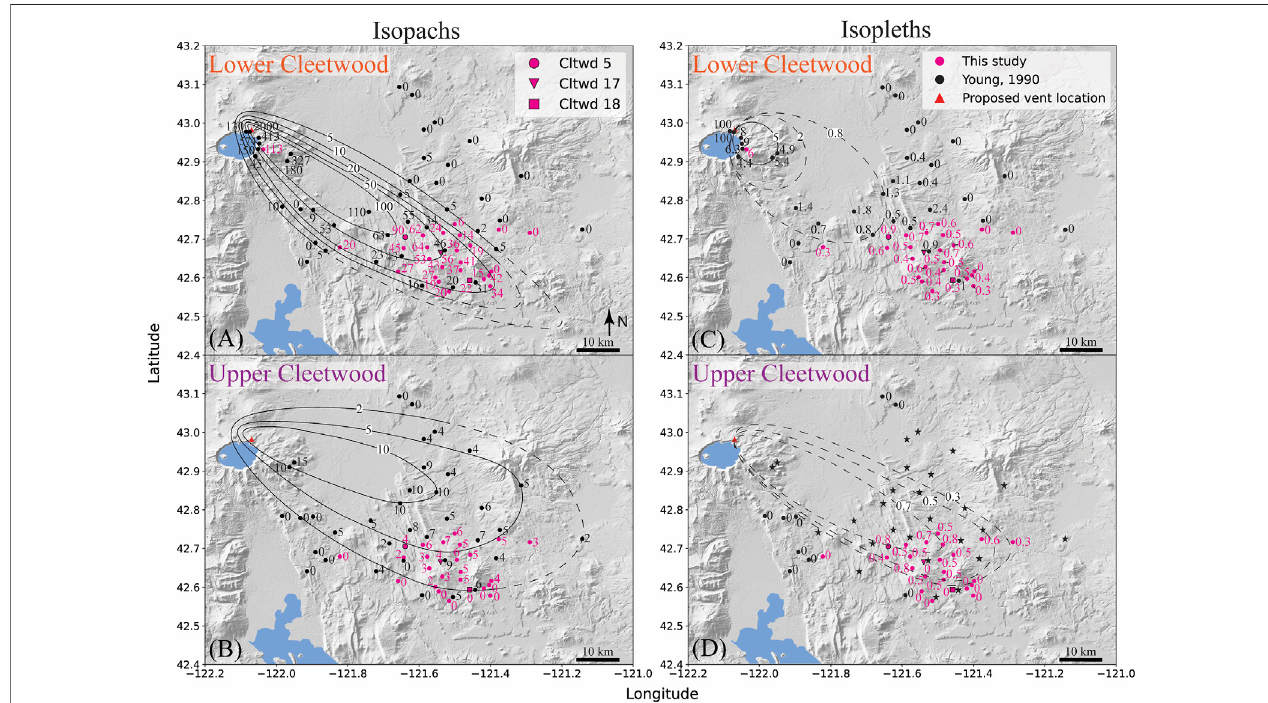
FIGURE4|(A-C) IsopachmapsforLlaoRock,lowerCleetwood,andupperCleetwoodoftheCleetwooderuption,respectively. (D-F) Maximumlithic(ML)isopleth maps for Llao Rock, lower Cleetwood, and upper Cleetwood respectively. Stars on the upper Cleetwood isopleth map represent locations where upper Cleetwood is present, but no ML data is available. All isolines are notated in centimeters. Background is global Earth relief (Tozer et al., 2019).